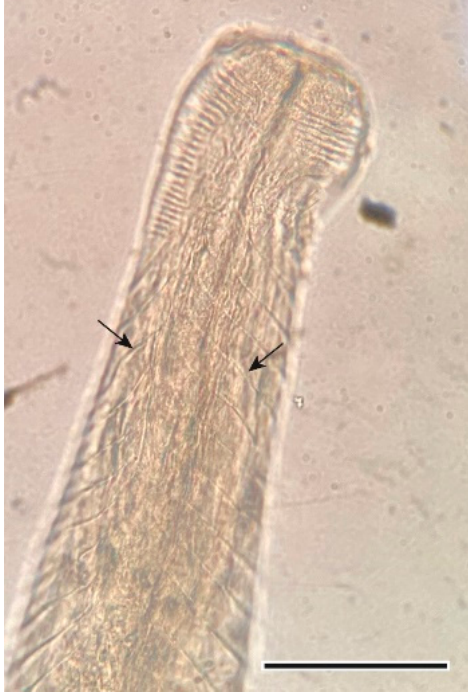
Figure 8. Cephalic extremity of a Heligmosomum costellatum female. Arrows point at cuticular striations. Scale bar = 100 µm.